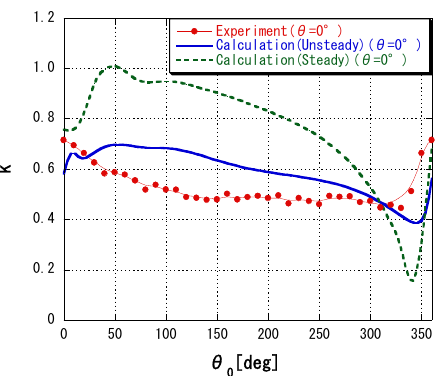
Fig. 17 Slip factor distributions ( φ =0.025 ， b / b 2